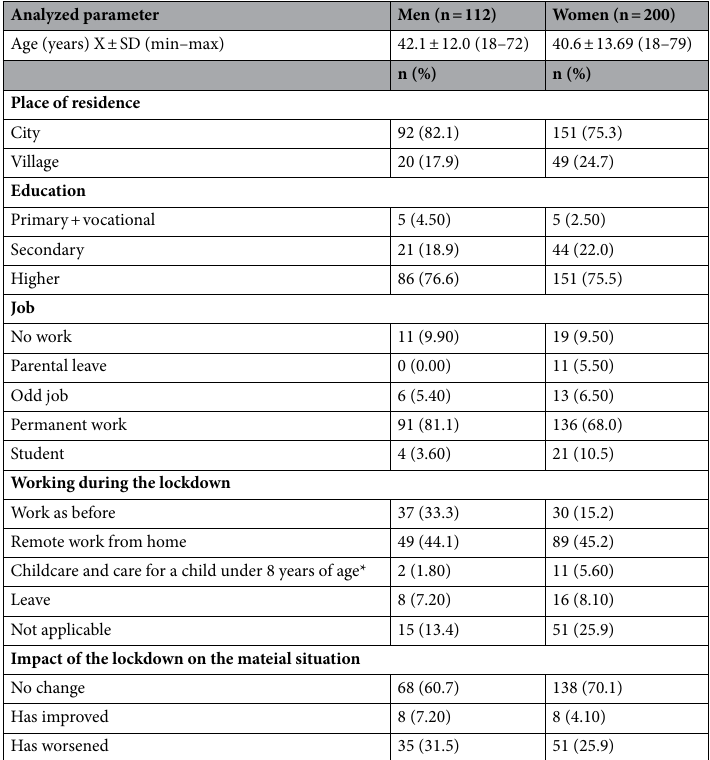
Table 1. General characteristics of the studied men and women (n = 312). n number of participants, % percentage of respondents, X average, SD standard deviation. *As a result of the Government’s decision to close nurseries and pre-schools linked to the COVID-19 pandemic, parents of children under the age of 8 have been able to stay at home and claim childcare allowance from 12 March 2020.